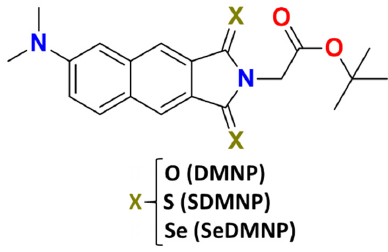
Figure 2. Molecular structures of DMNP, SDMNP, and SeDMNP, herein investigated, created with the free ChemSketch software available at www.acdlabs.com.